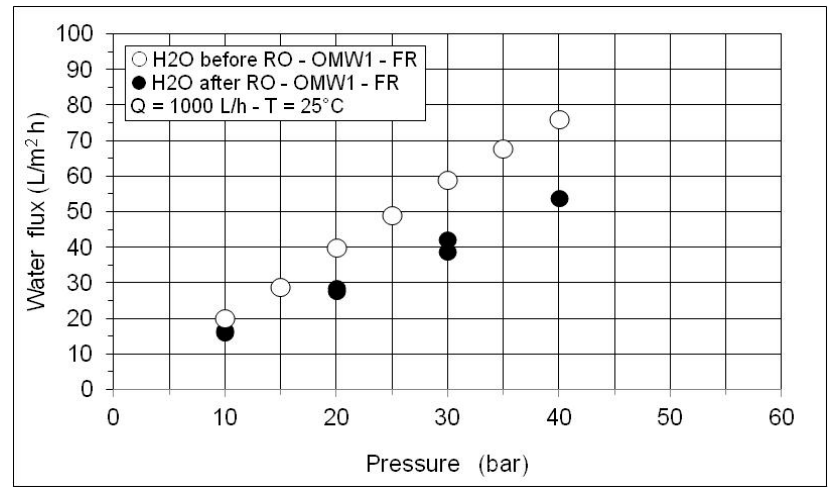
Figure 6. Permeate flux as a function of operating pressure at VCR = 10.5 (Feed: MF permeate of OMW1-FR).